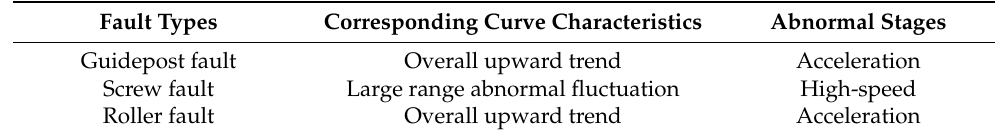
Table 1. Fault types and corresponding attributes.